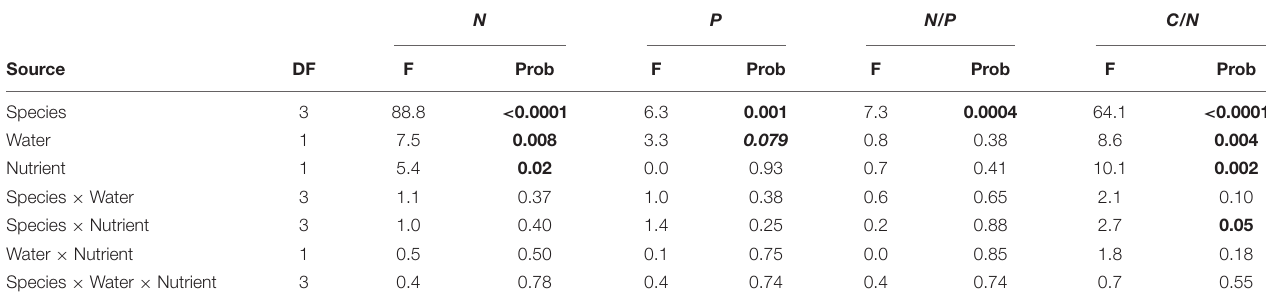
FIGURE 2 | Root chemistry in response to water and nutrient availability treatments for each of the studied species. Water (W), Low/High water availability (LW, HW); Nutrients (N), Low/High nutrient availability (LN, HN). Data points represent averages across shelters/replicates with standard error ( n = 6). See Table 2 for statistical test across species. CACU, Casuarina cunninghamiana ; EUSI, Eucalyptus sideroxylon ; EUTE, Eucalyptus tereticornis ; PIRA, Pinus radiata . TABLE 2 | Results from statistical analysis of impacts of water and nutrient availability across plant species on root chemistry (N and P content, N/P and C/N).